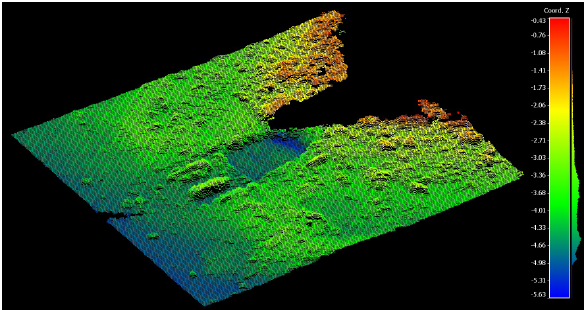
Figure 3. Digital Terrain Model (DTM) of the underwater archaeological site and the surrounding area (grid at 0.1 m)